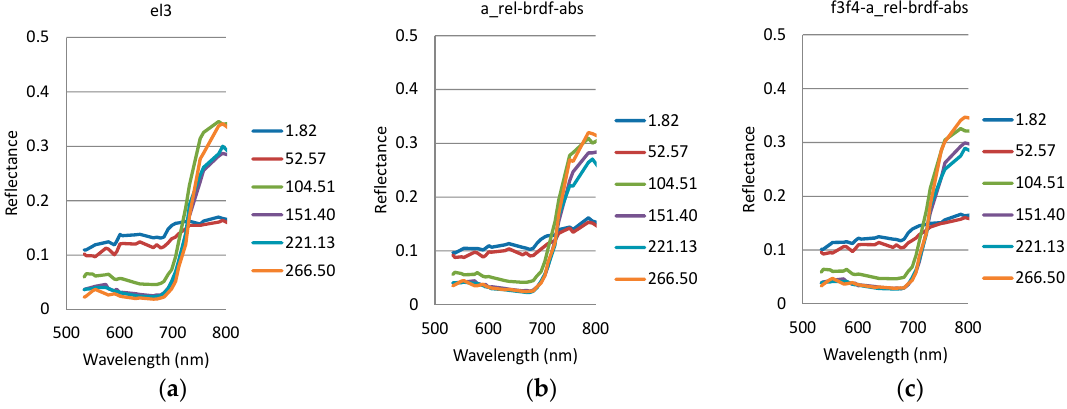
Figure 17. Spectra sampled for selected soil (dry biomass < 53 g/m 2 ) and vegetation samples (dry biomass > 100 g/m 2 ) from the most nadir images; the legend shows the measured dry biomass as g/m 2 for each sample. ( a ) Full dataset with empirical line based reflectance calibration and no BRDF correction; ( b ) the full dataset and ( c ) the dataset with flights f34 with BRDF and relative corrections and the reflectance calibration.